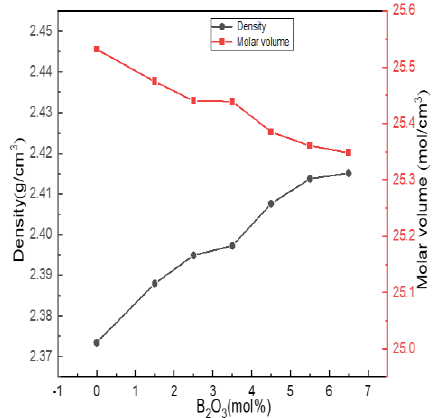
13 of 17 Figure 6. Change curve of mechanical properties of Li 2 O − Al 2 O 3 − SiO 2 series glass with different B 2 O 3 contents. Vickers hardness was between 605 and 720 MPa. When the content of B 2 O 3 (mol%) increased from 0 to 5.5, boron and aluminum mainly existed in four-coordinated forms, acting as network formers. N 4 and Q 4(0Al) increased with the increase in boron content, and the network structure shrank, while the density and integrity of the structure were en- hanced, and the ability to resist external force damage was enhanced. When B 2 O 3 (mol%) = 6.5, the values of N 4 , Q 4(0Al) and Al IV were all lower than when B 2 O 3 (mol%) = 5.5. The content of SiO 2 in the glass exceeded 60 mol%, and the network modifiers containing N 3 , Al V and Al VI were not only connected with the silicon skeleton but also entered the glass cavity to improve the network density and the content of N 4 , while Q 4(0Al) and Al IV always dominated. Therefore, the increased content of network mod- ifier did not change the overall change trend of Vickers hardness but only slowed down its growth trend. 4.2.3. Physical Properties